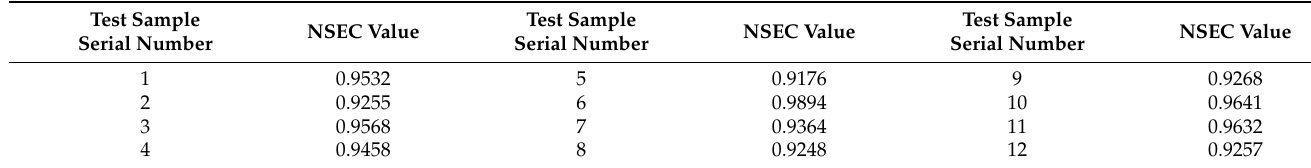
Table 5. Test sample predicted value vs. true value results.